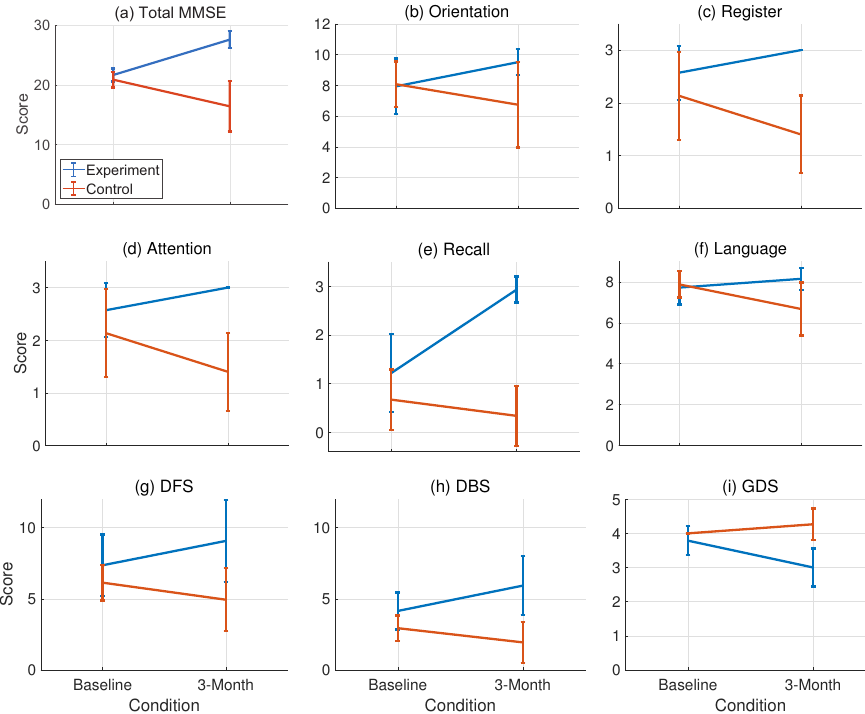
Figure 3. The means and the standard deviations of the total MMSE score and its category scores at baseline and post-intervention ( a – f ). The means and the standard deviations of the DFS, DBS, and GDS scores by groups at baseline and post-intervention ( g – i